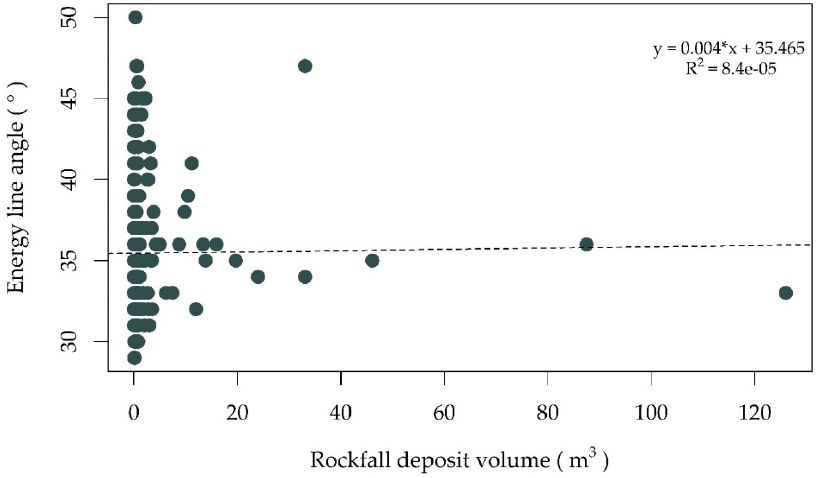
Figure 13. Scatter plot showing correlation between the rock deposit volumes (m 3 ) and energy line angles (°).